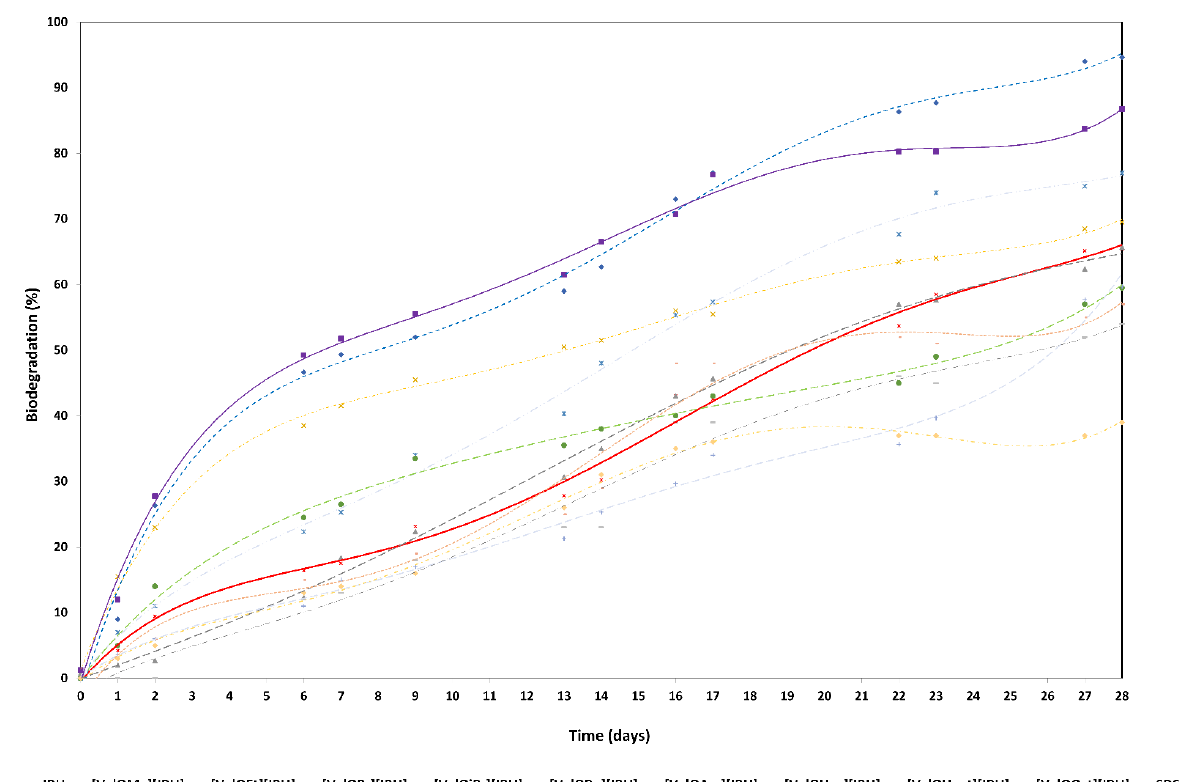
Figure 4. Biodegradation curves for the ibuprofen (red line), L-valine alkyl ester ibuprofenates, and SDS (as the reference compound—purple line).